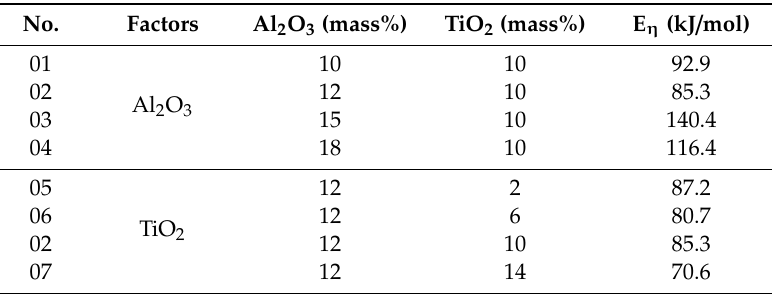
Figure 5. Natural logarithm of viscosity against reciprocal of temperature ( a ) differentAl 2 O 3 content ( b ) different TiO 2 content. Table 2. Viscosity activation energy of slags.